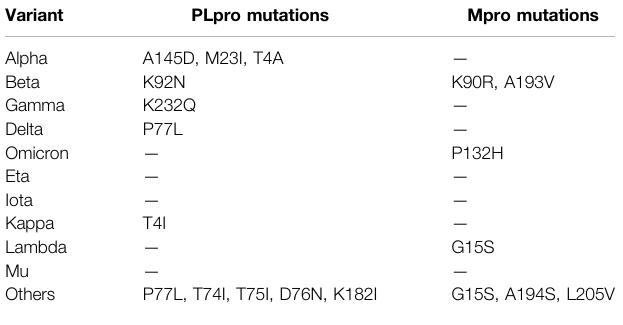
TABLE 5 | Mutations identi fi ed in variant of concern genomes.